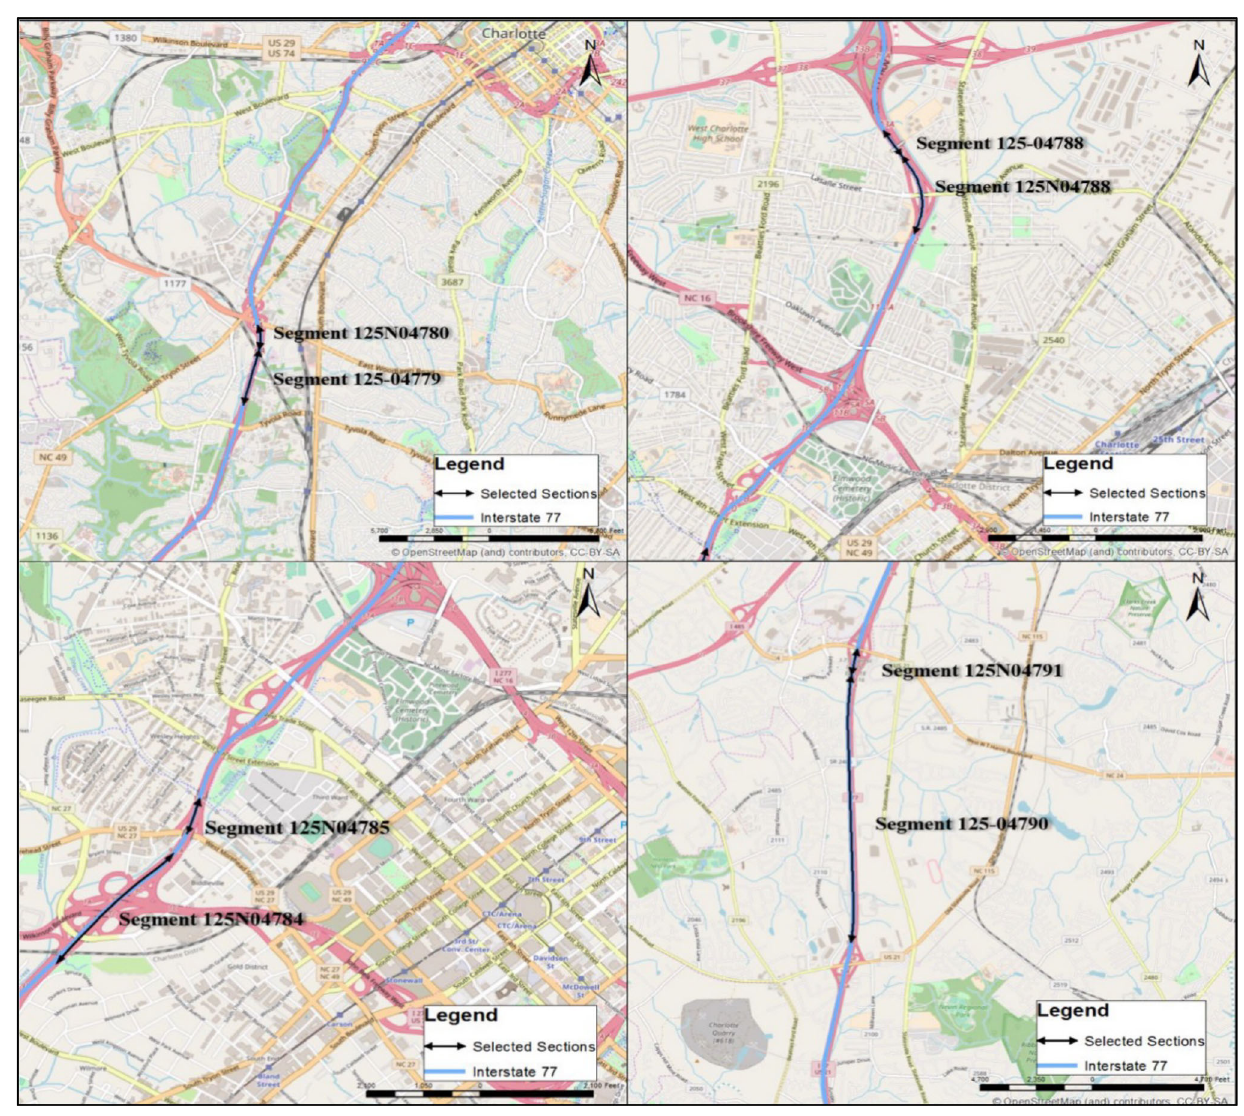
Fig. 3 Location of selected I-77